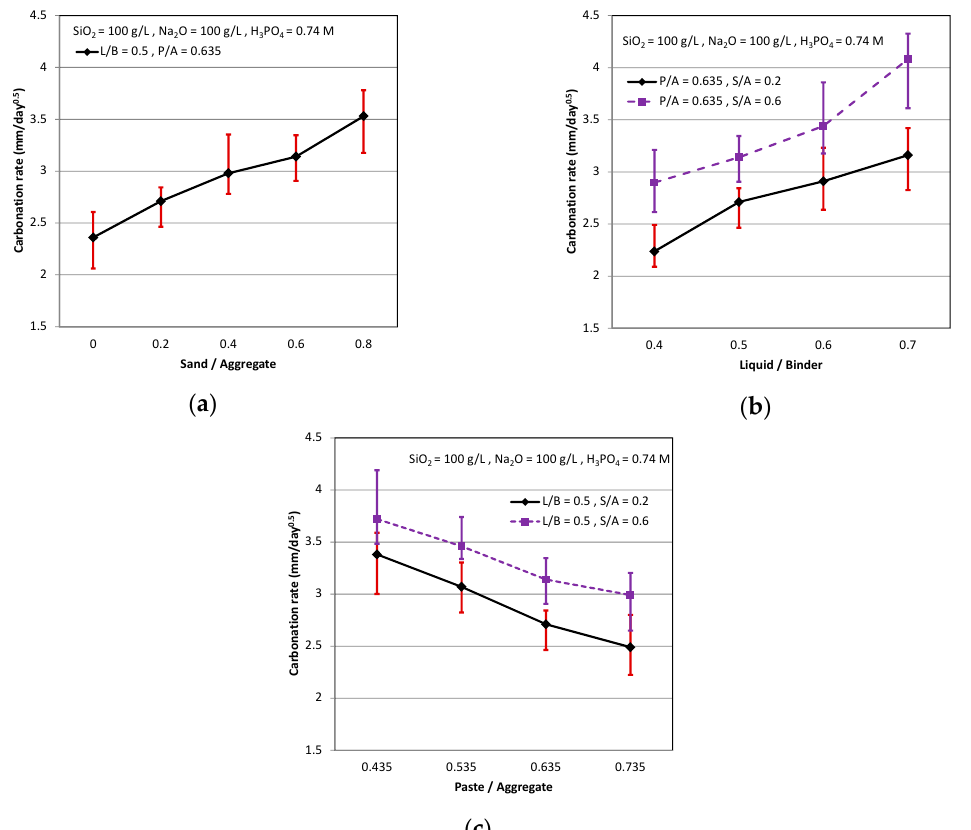
Figure 7. Carbonation rate (pH indicator): ( a ) P/A = 0.635, L/B = 0.5; ( b ) P/A = 0.635, S/A = 0.2 & 0.6; and ( c ) L/B = 0.5, S/A = 0.2 & 0.6.